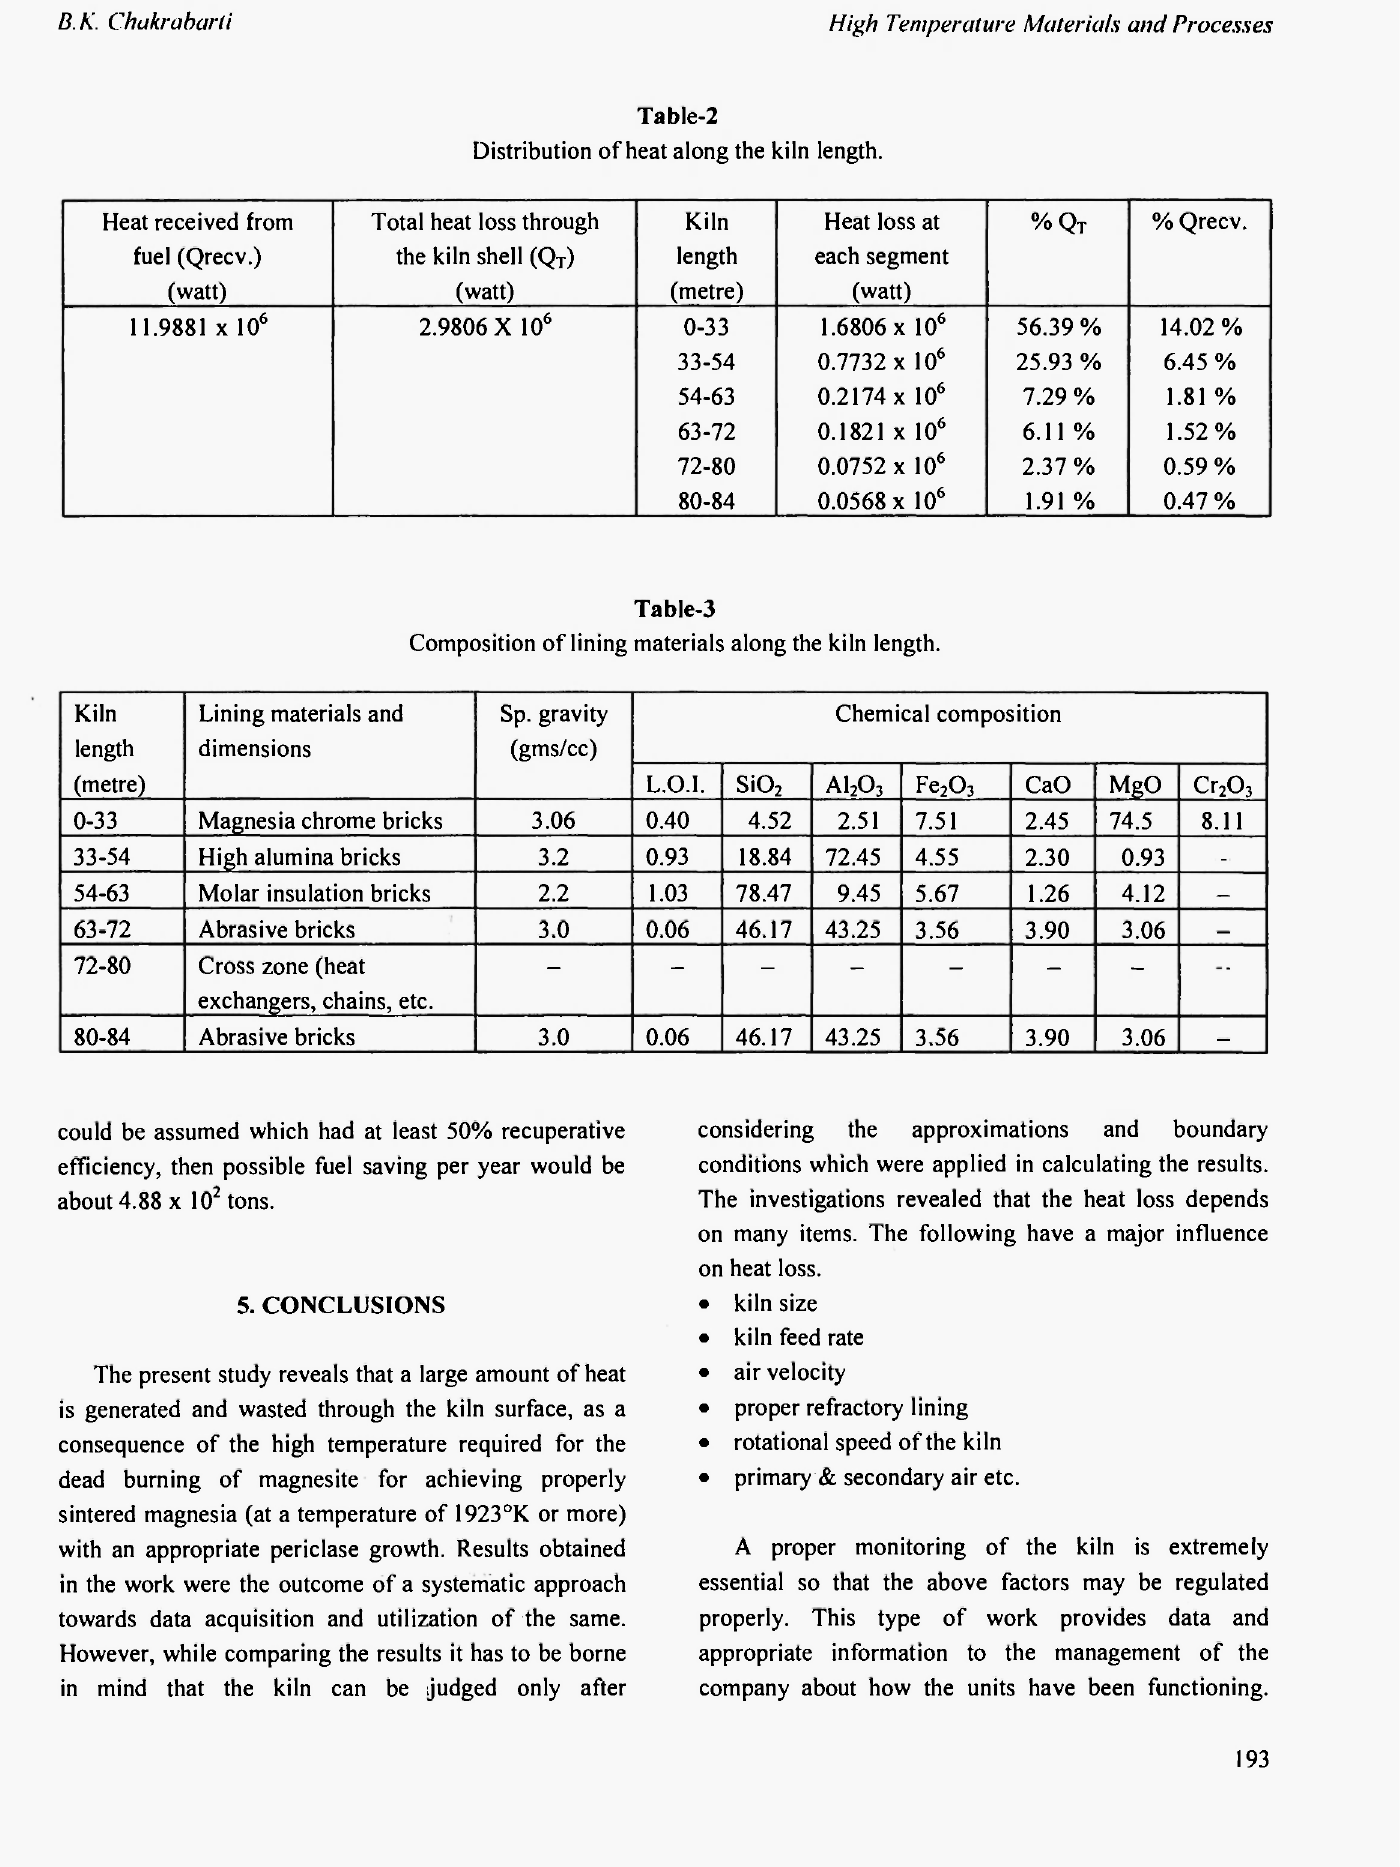
Distribution of heat along the kiln